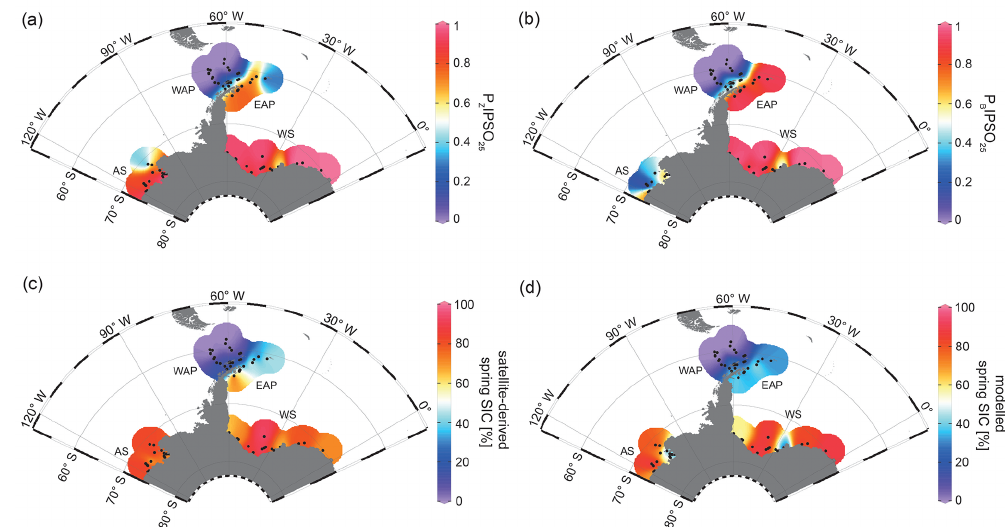
Figure 4. Distribution of the sea-ice index PIPSO 25 in surface sediment samples, with (a) P Z IPSO 25 based on HBI Z-triene and (b) P B IPSO 25 based on brassicasterol, (c) satellite-derived spring SIC (%) and (d) modelled spring SIC (%). The abbreviations used in the figure are as follows: AS – Amundsen Sea, WAP – West Antarctic Peninsula, EAP – East Antarctic Peninsula and WS – Weddell Sea. Maps were generated using the Ocean Data View Software (Schlitzer,